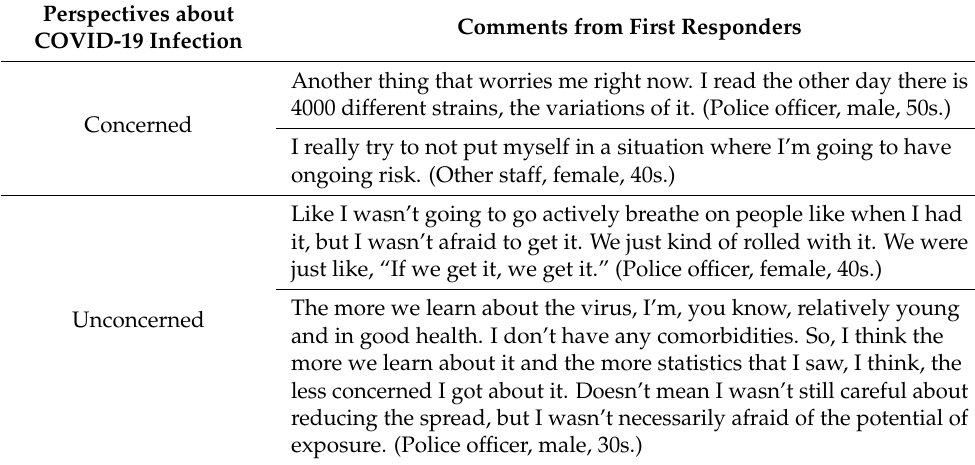
Table 2. Perceptions about COVID-19 infection.